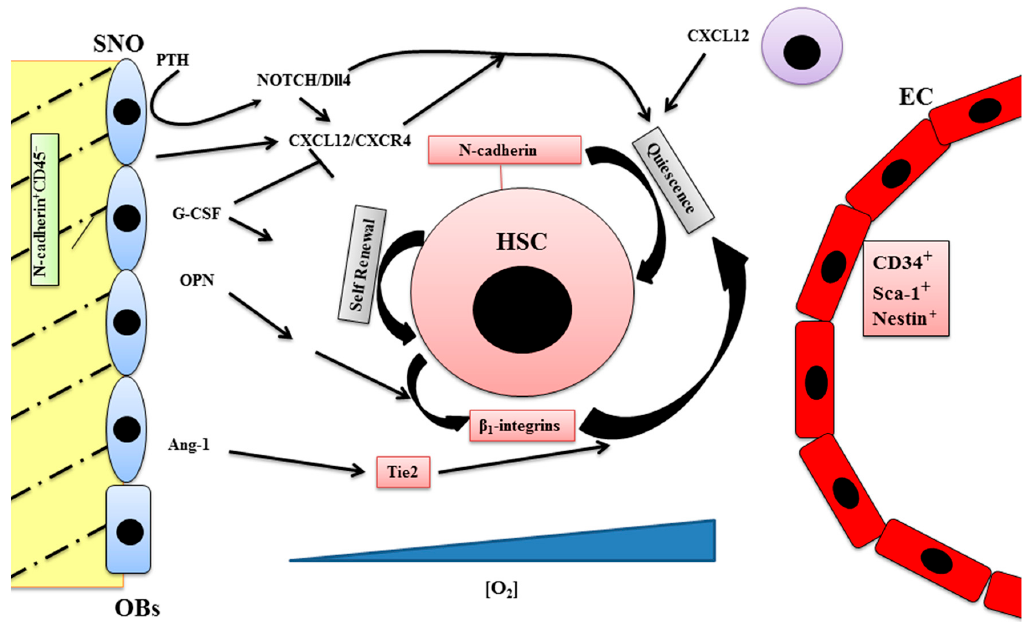
Figure 1. The endosteal niche is a complex structure inside which all the components, such as stem cells, progenitor cells, stromal cells, growth factors, and extracellular matrix (ECM) molecules participate in the regulation of hematopoiesis. Spindle-shaped N - cadherin + CD45 − osteoblastic cells (SNO); osteoblasts (OBs); endothelial cells (EC); hematopoietic stem cells (HSC); granulocyte colony-stimulating factor (G-CSF) ; osteopontin (OPN); parathyroid hormone (PTH); δ like ligand 4 (Dll4); C-X-C chemokine receptor type 4 (CXCR4); stromal cell derived factor-1/C-X-C motif chemokine 12 (CXCL12); angiopoietin receptor-2 (Tie2); angiopoietin-1 (Ang-1); Notch/translocation − associated Notch homologue (NOTCH). Blue triangle: oxygen gradient.